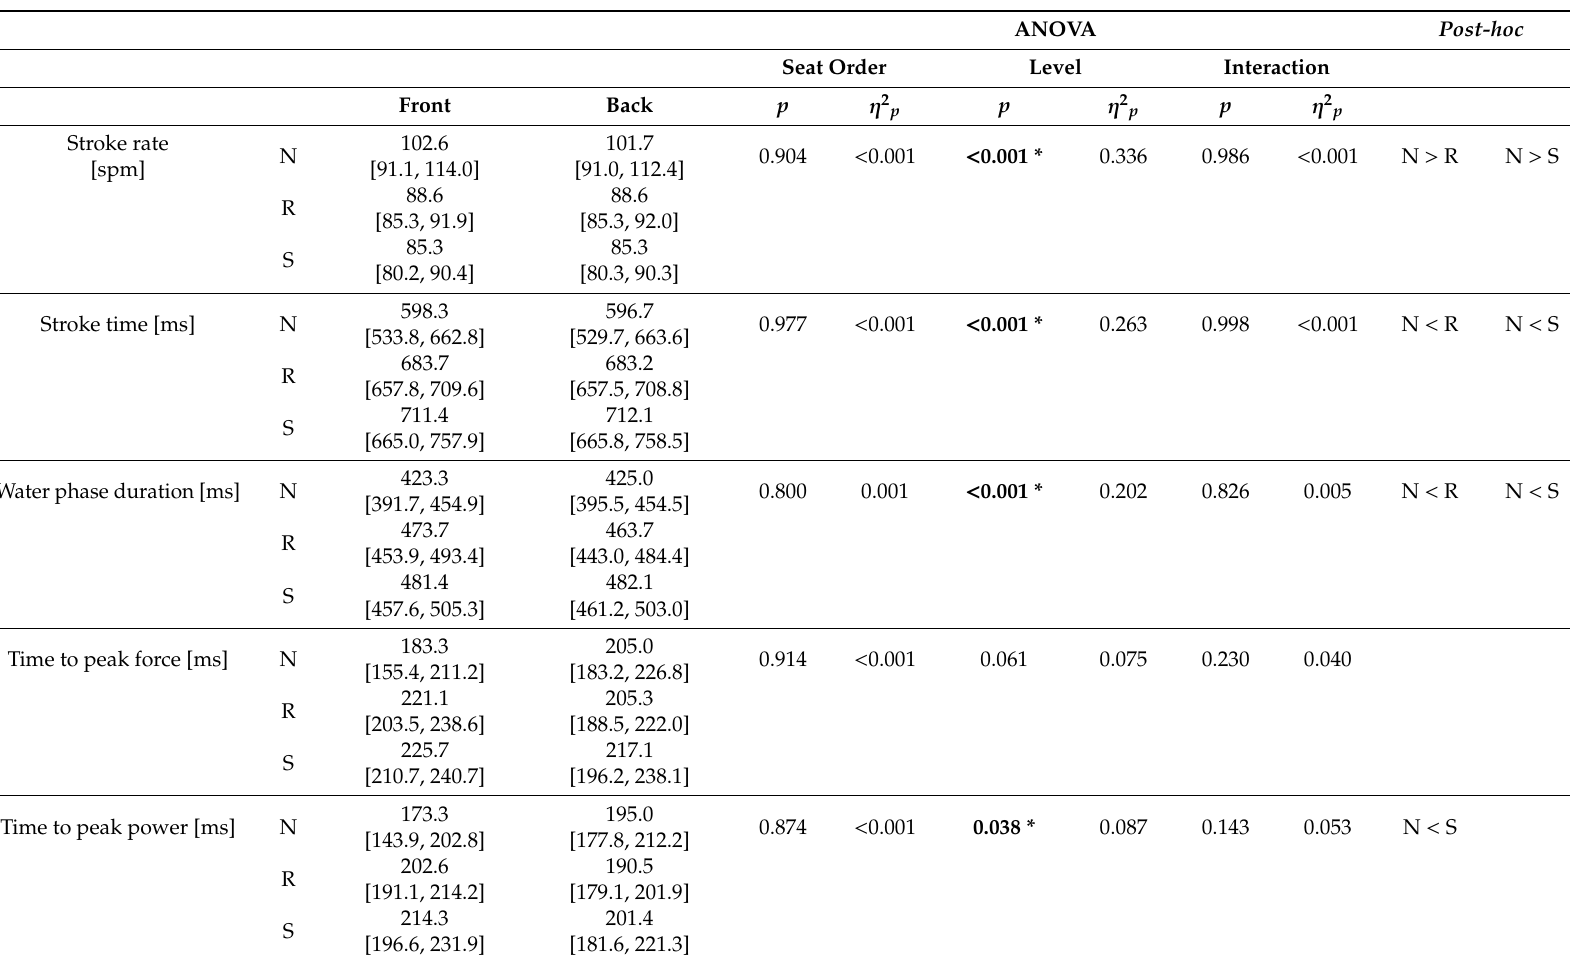
Table 4. Temporal variables of front and back paddlers of K2 crews during a 200-m maximal e ff ort sprint kayaking. ANOVA Post-hoc Seat Order Level